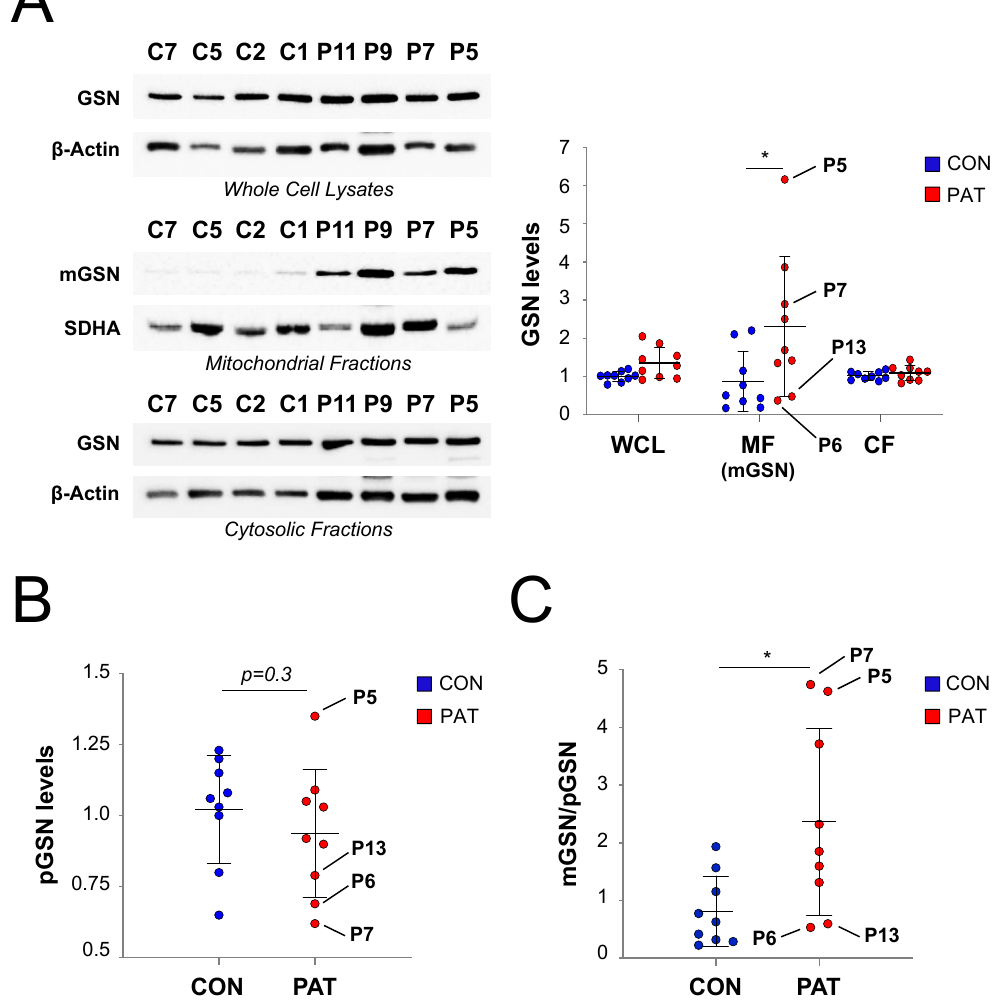
Figure 7. Relative mGSN and pGSN levels in blood samples from patients with mitochondrial OXPHOS disease (MD). ( A ) In total, 15 µ g of protein extracts from whole-cell lysate, mitochondrial, and cytosolic fractions from PBMCs isolated from healthy controls (C1–C9, CON) and MD patients (P5-P13, PAT) were separated on 10% SDS-PAGE gels. GSN levels were analyzed by immunoblotting, using β –actin and SDHA as loading controls. (Graph) The signals from three independent biological replicates per fraction were quantified and normalized by their respective loading controls. Each data point represents an individual subject and overall data are presented as the mean ± SD relative to the mean control value. ( B ) Relative pGSN levels from the blood samples of healthy controls (CON) and MD patients (PAT) were determined by ELISA. Each data point represents an individual subject, and overall data are indicated as the mean ± SD from four measurements relative to the mean control value. ( C ) Calculation of the mGSN:pGSN ratios in blood from healthy controls and MD patients. Each data point represents an individual subject, and overall data are indicated as the mean ± SD, relative to the mean control value. The four patients with the most extreme mGSN:pGSN ratios (P5, P6, P7, P13) are indicated. For ( A – C ), Mann–Whitney U test: * p < 0.05. GSN, cytosolic GSN; mGSN, mitochondrial GSN;